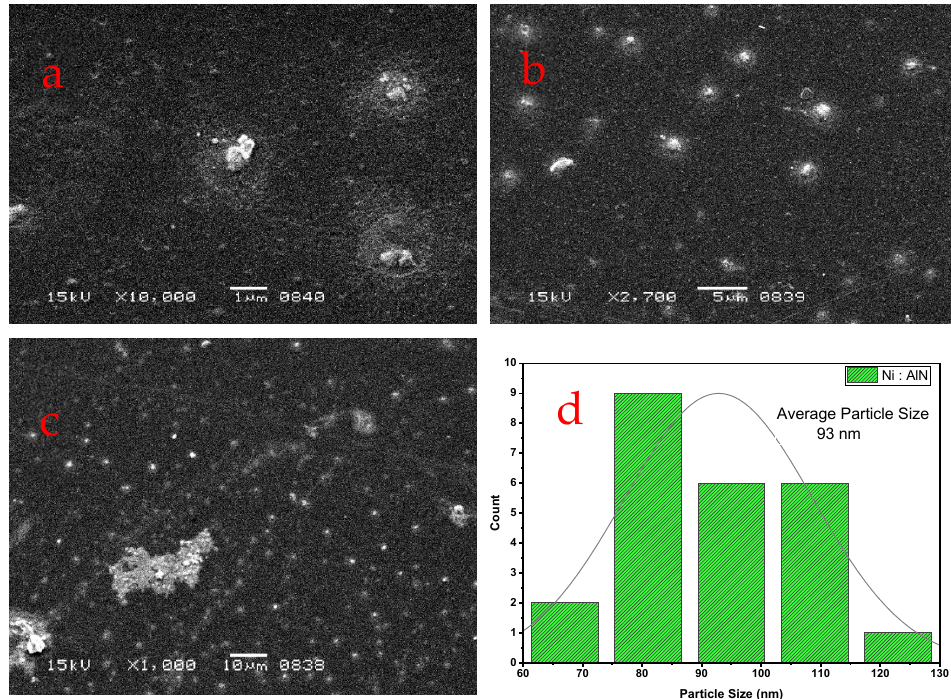
Figure 4. SEM of Ni: AlN thin films at different magnification powers: ( a ) 1 µ m, ( b ) 5 µ m, and ( c ) 10 µ m). ( d ) Histogram for particle size.